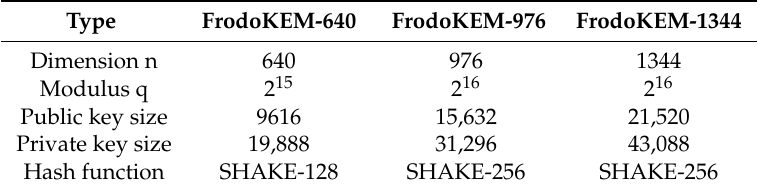
Table 2. Variable Information of FrodoKEM.